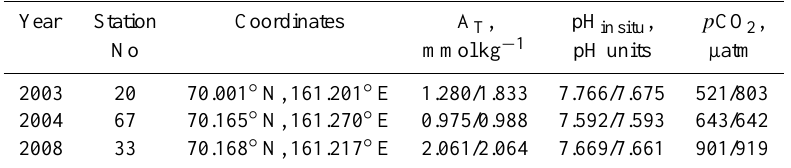
Fig. 14. Profiles of temperature ( ◦ C) (a) , salinity (b) , CDOM (µgl − 1 ) (c) , and turbidity (Nephelometric Turbidity Units, NTU) (d) at the stations 20, 67 and 33 in September 2003, 2004, and 2008. Coordinates of the stations are pointed in Table 3. Table 3. Carbon system characteristics of surface/bottom layers at stations 20, 67, and 33.